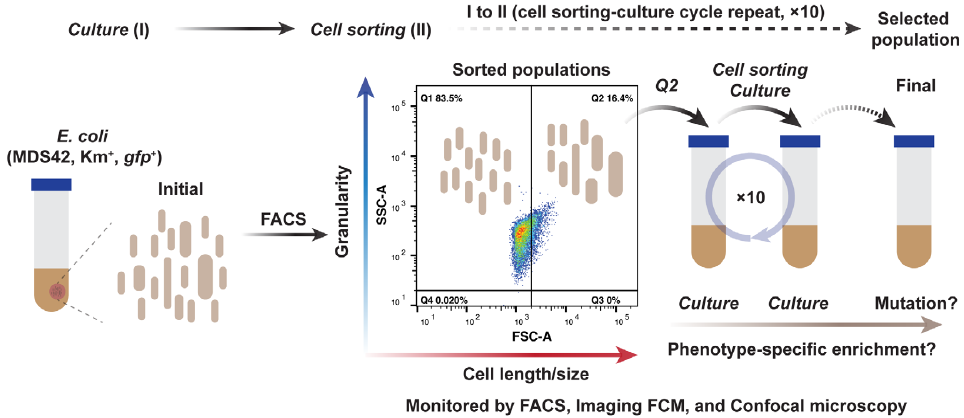
Figure 1. Schematics of strategies for cell sorting-guided cell size selection. It shows the rounds of directed size selection by using FACS. The cells in bigger sizes were defined as the gated cells from Q2 based on the forward scatter value (FSC). The Q2-gated cells were then subjected to sorting-culture cycles 10 times. Parallel experiments with continuous passages without cell sorting were conducted as an internal control. Three replicates from control (Control-A, -B, -C) and sorting-guided (FACS-A, -B, -C) groups were investigated to monitor cell morphology and genomic changes.